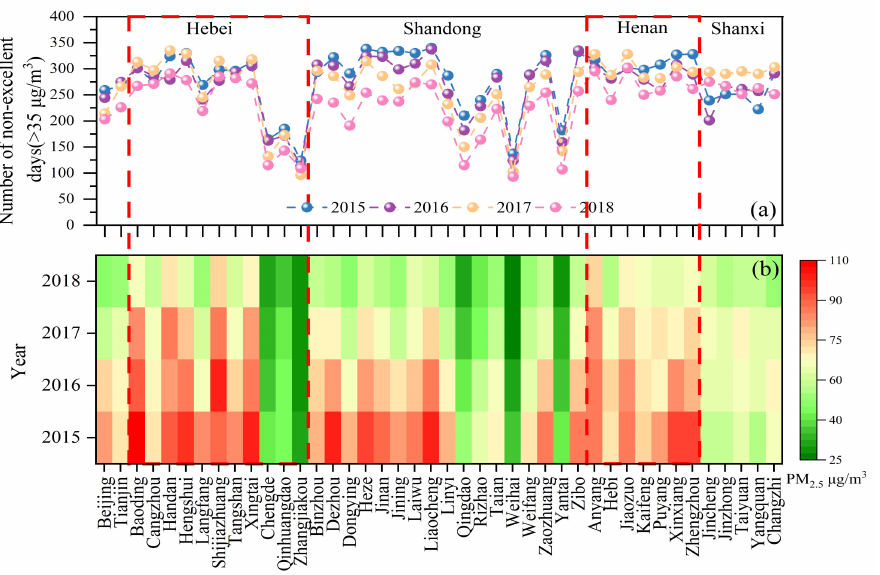
Figure 3. The number of non-excellent days ( a ) and variations of annual PM 2.5 concentrations ( b ) by city from 2015 to 2018 in the NNCP